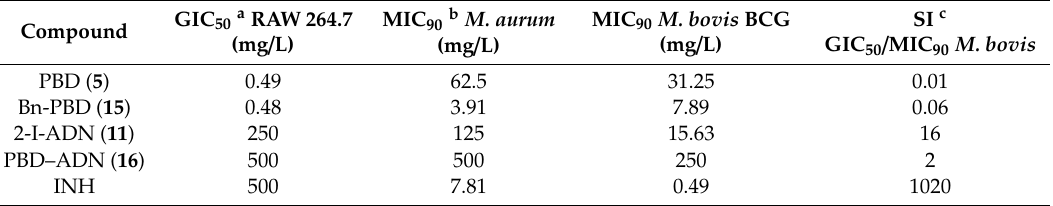
Table 1. Anti-mycobacterial and cytotoxic activity evaluation of 5 , 11 , 15 and 16 using the high-throughput spot-culture growth inhibition assay (HT-SPOTi) technique.